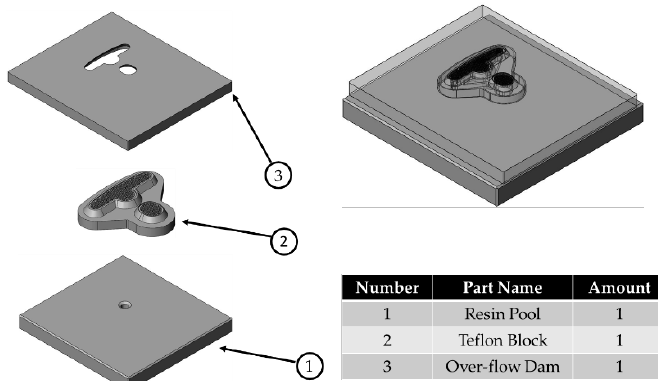
Figure 2. Runner design.